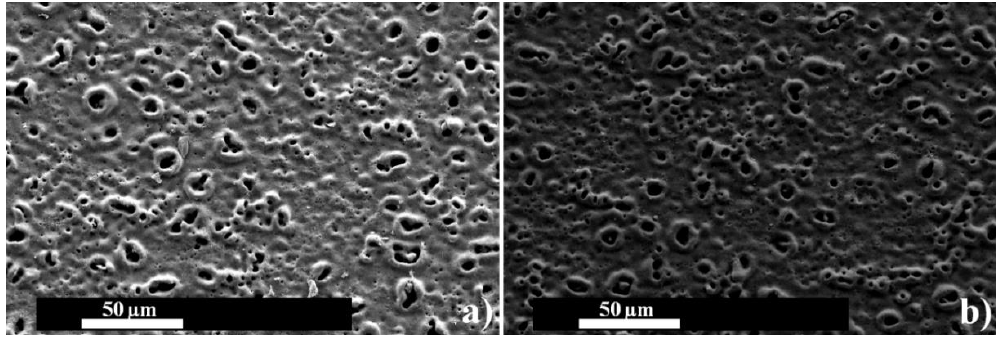
Figure 3. Surface SEM morphologies of the coatings: ( a ) the MAO coating and ( b ) Cu-based MAO coating.